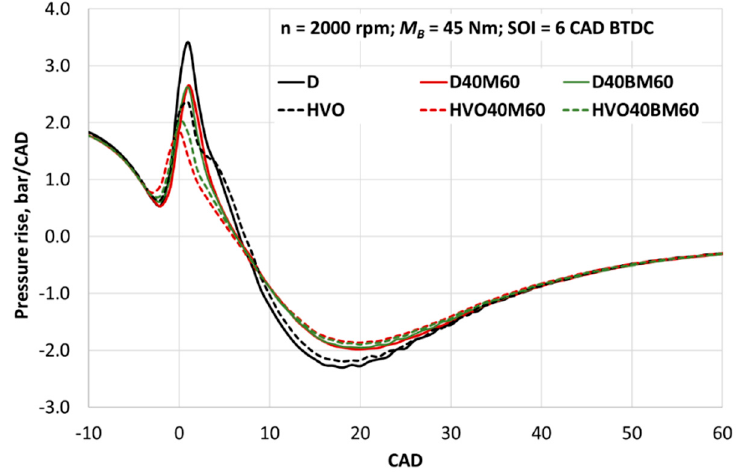
Figure 13. Pressure rise in the cylinder depending on fuel composition.